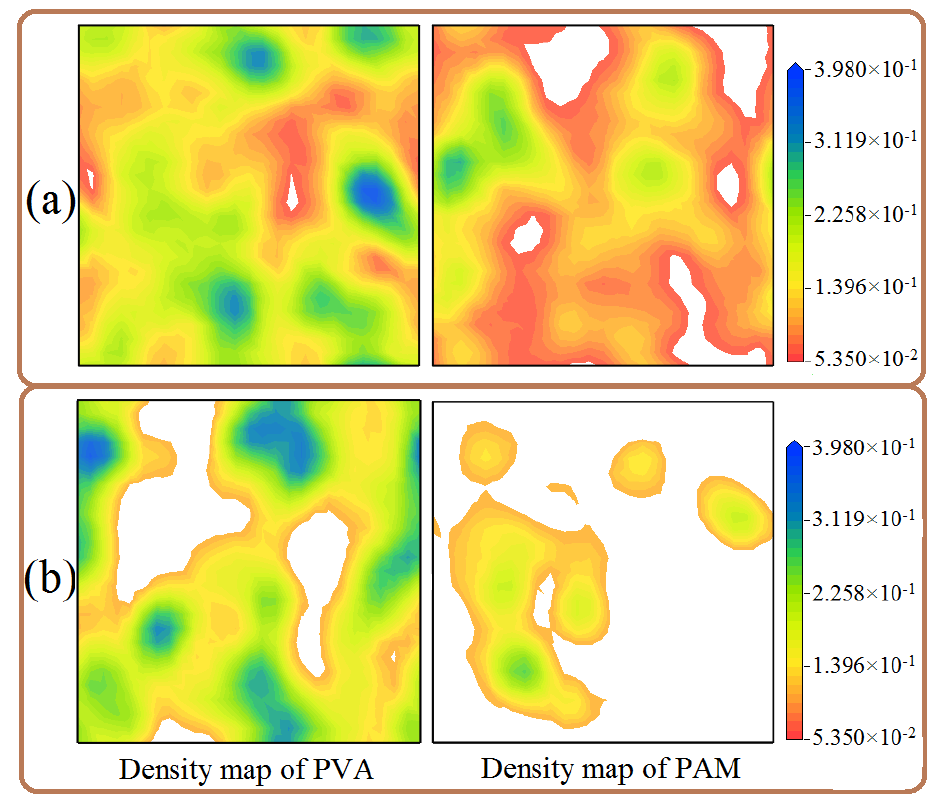
Figure 16. Concentration profile maps of PAM and PVA in 10% PVA/10% PAM/1.5% nano-silica blended hydrogels in the YZ plane with shear rates of ( a ) 0.00 and ( b ) 0.16.